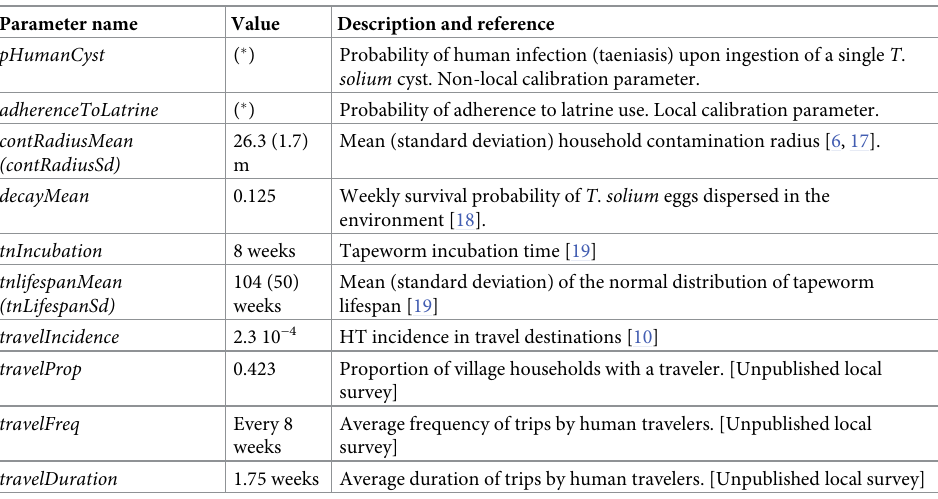
Table 3. Human module